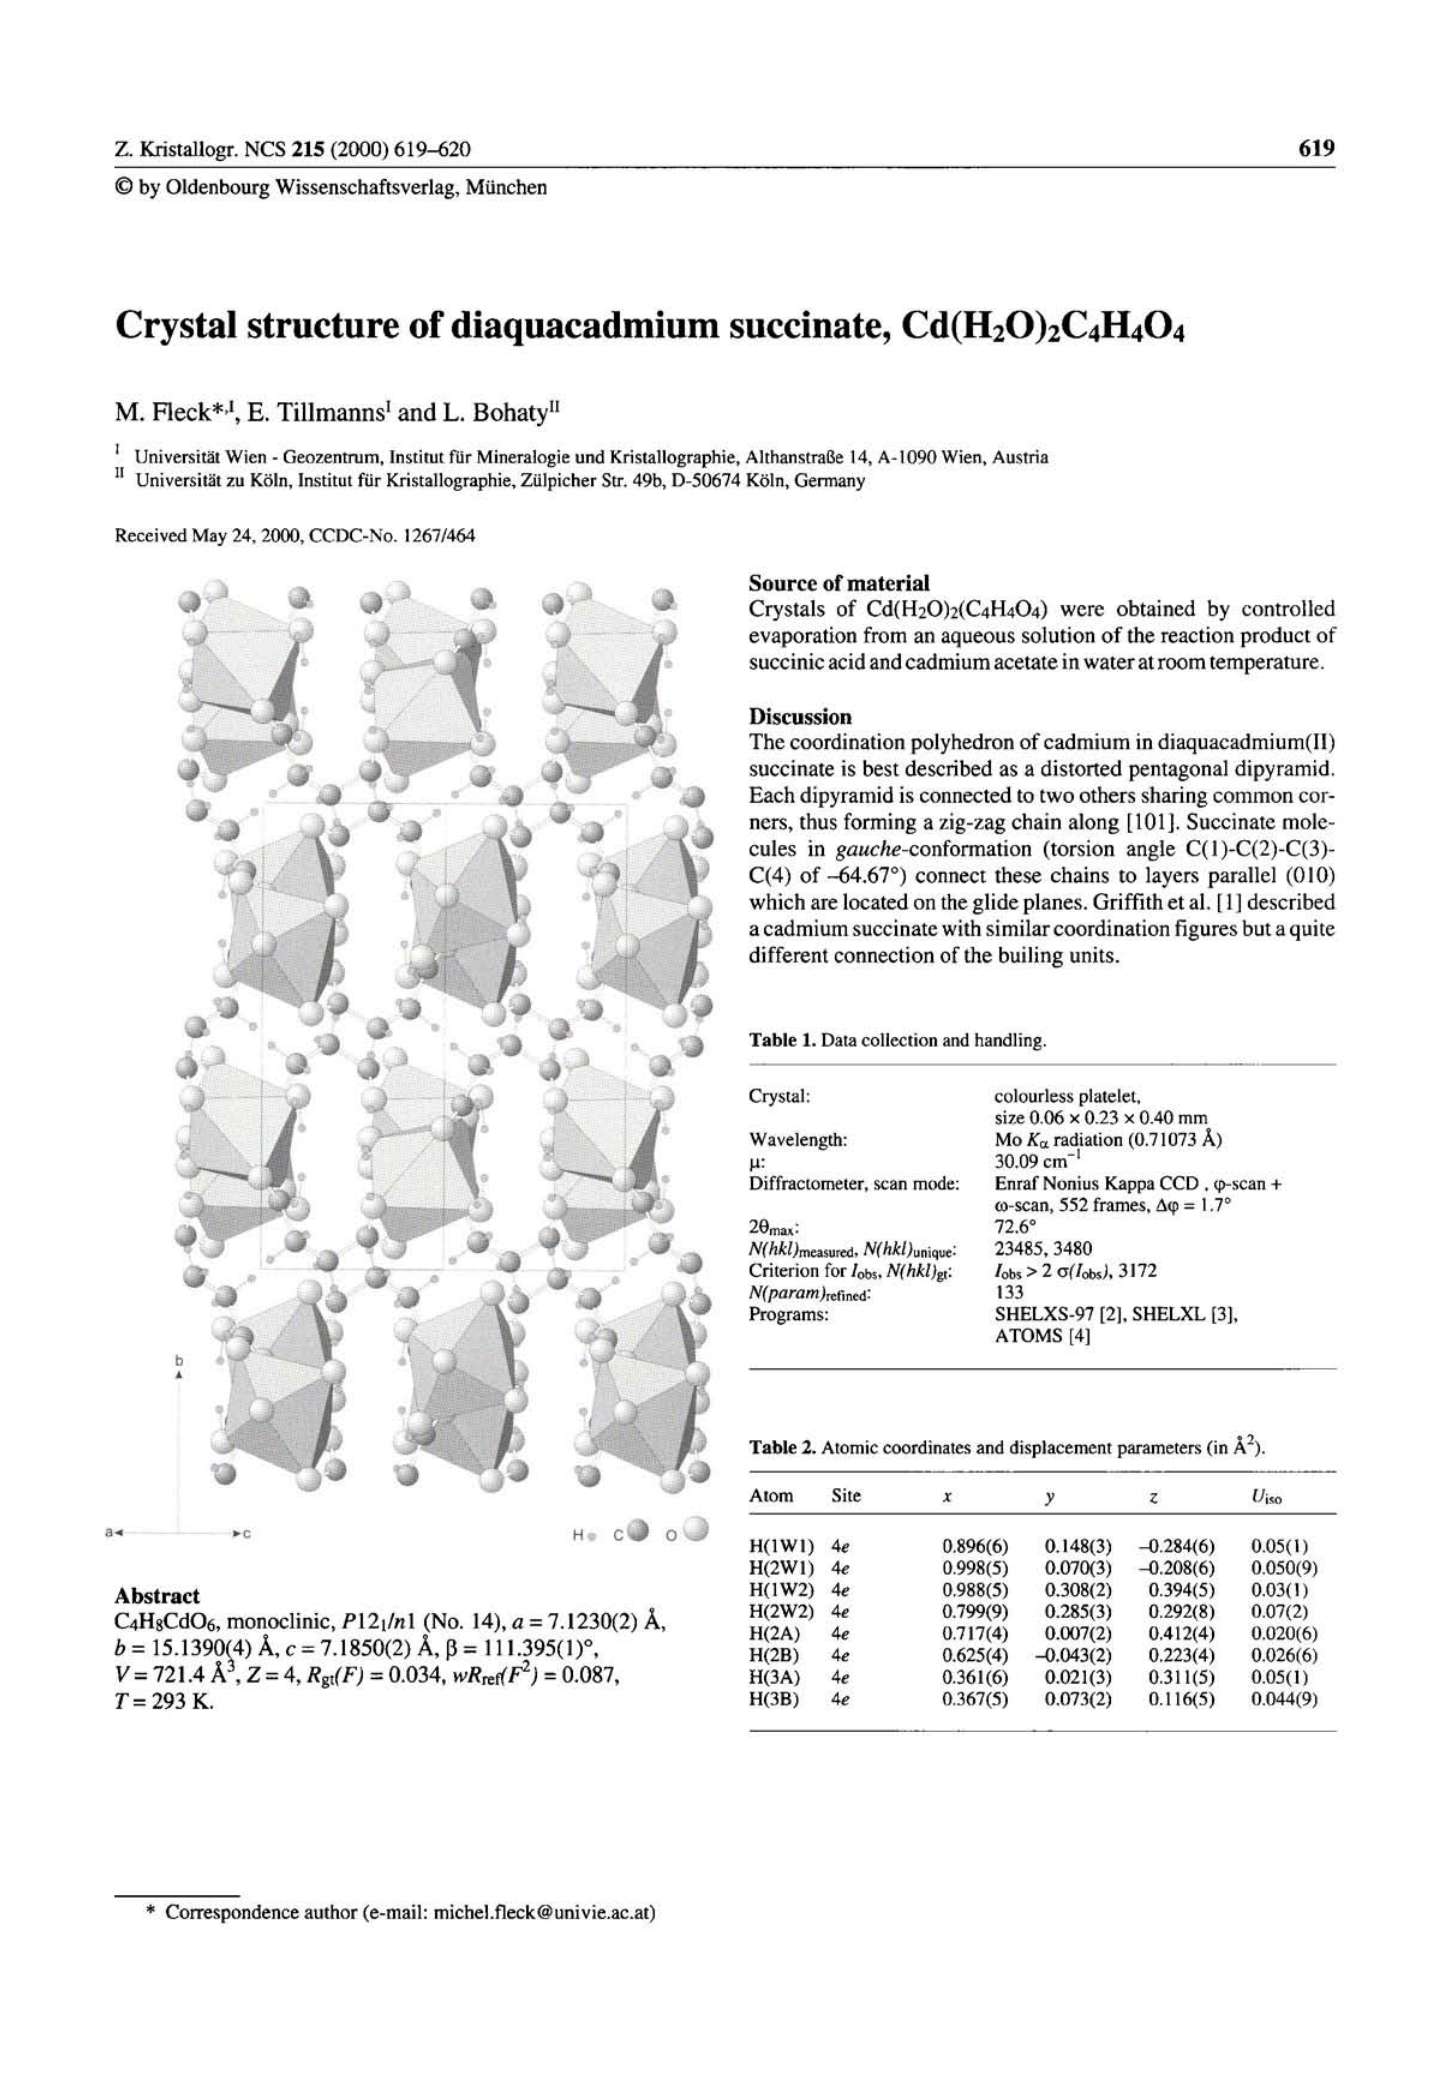
Table 2. Atomic coordinates and displacement parameters (in